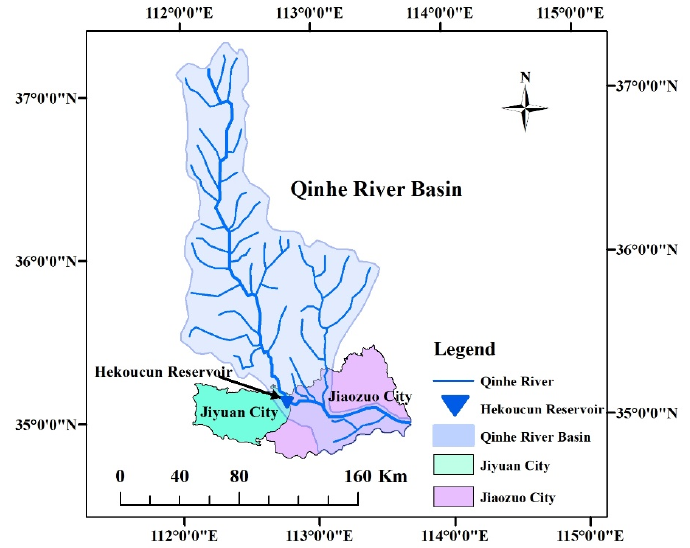
Figure 2. Map of Qinhe river basin and water supply cities.